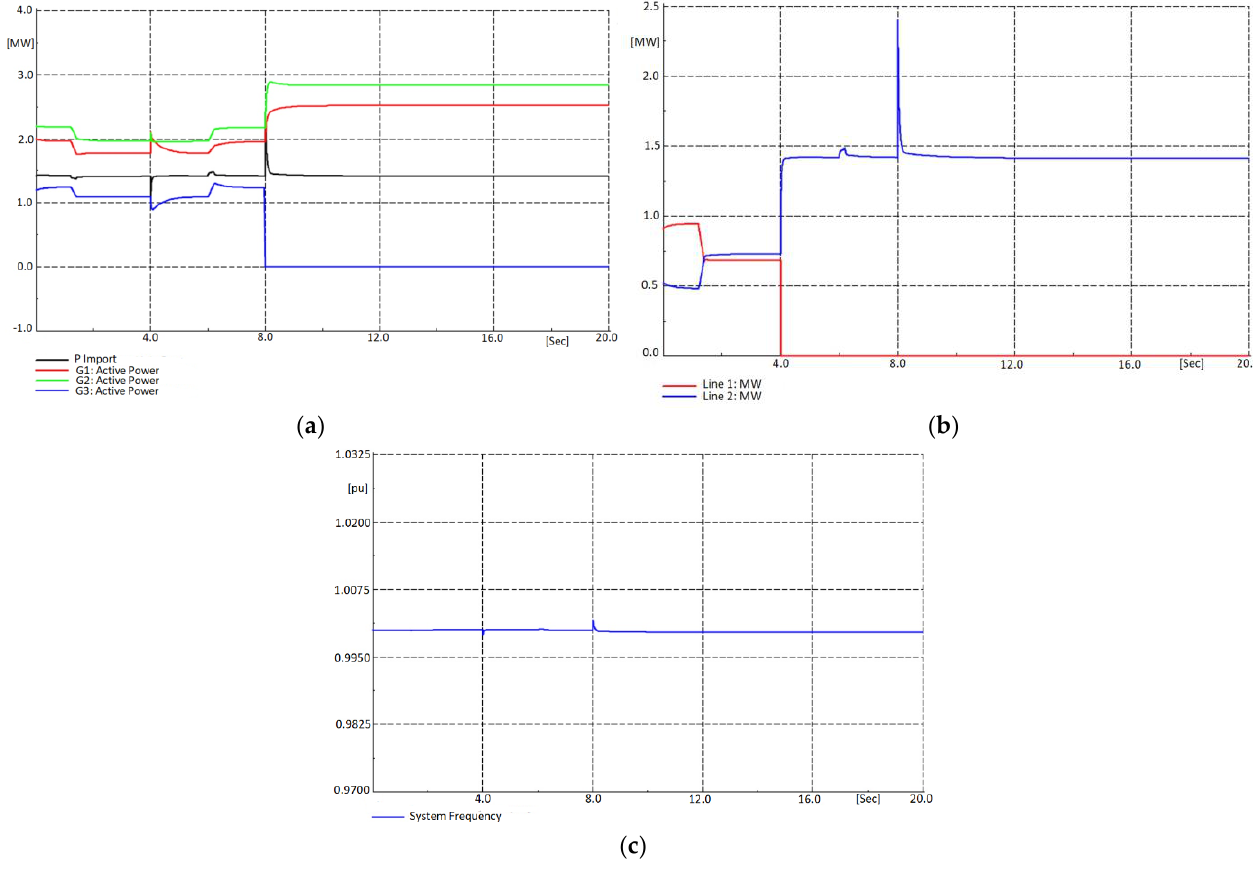
Figure 9. Simulation results of Case study-3. ( a ) Active Power of G1, G2 and G3; ( b ) Active Power Flow on line 1 and line 2; ( c ) Frequency of the Micro Grid. Flow on line 1 and line 2; ( c ) Frequency of the Micro